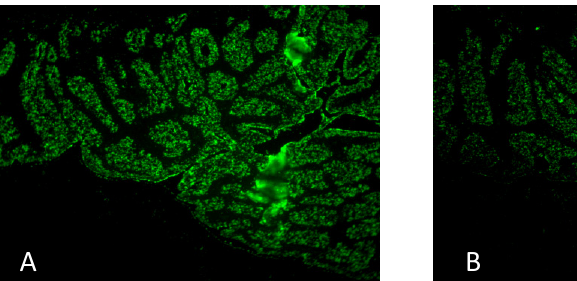
Figure 4. Representative fluorescence microscopy images of FITC-labelled H. pylori adhering arabinogalactan protein F2 from R. niger (1 mg/mL) ( B ). H. pylori pre-treated with acidic human milk oligosaccharides (positive control) ( C ), Images (magnification 100×)